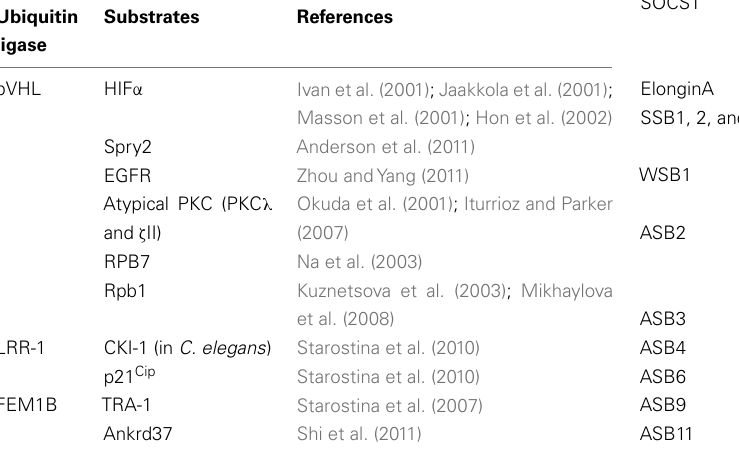
Table 1 | Cul2-type ubiquitin ligases and corresponding substrates.